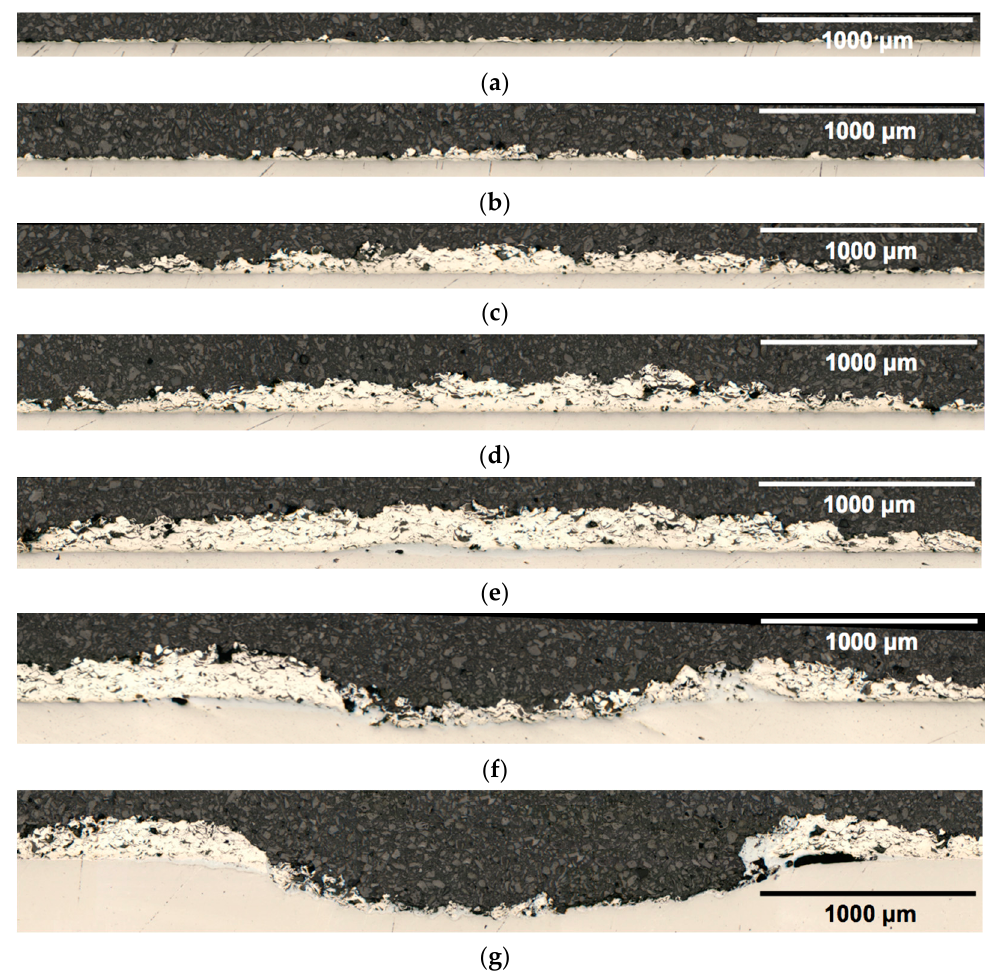
Figure 6. Deposition of mixtures of nickel and NCG at a total of 30 vol% graphite on titanium using laser powers ranging from 0–1744 W. ( a ) 30 vol% graphite mixture on Ti—0 W. ( b ) 30 vol% graphite mixture on Ti—99 W. ( c ) 30 vol% graphite mixture on Ti—492 W. ( d ) 30 vol% graphite mixture on Ti—805 W. ( e ) 30 vol% graphite mixture on Ti—1118 W—Substrate melting visible in